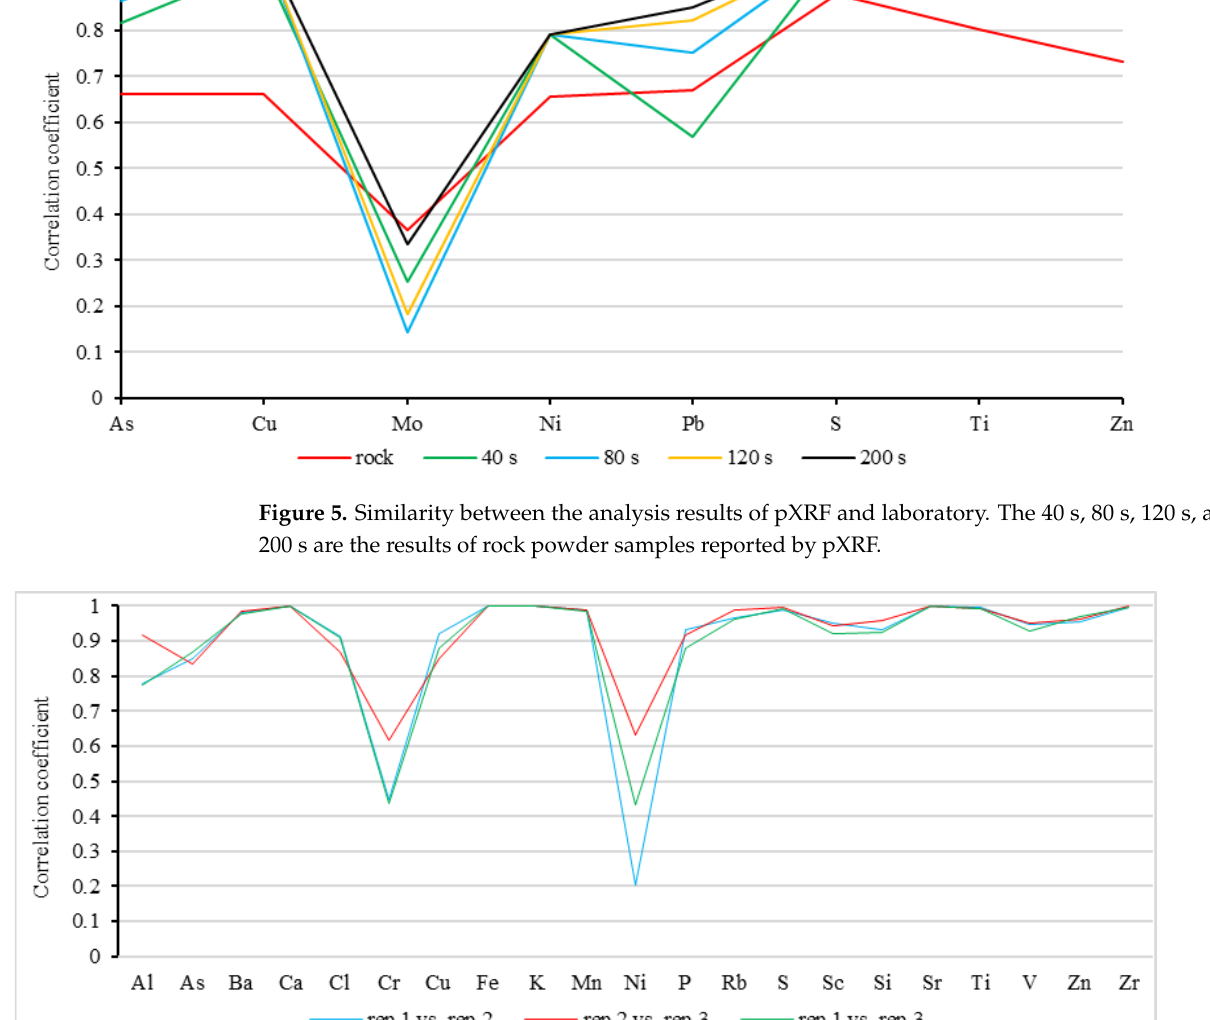
Figure 6. Correlation between different repeated measurements of rock powder samples by pXRF.